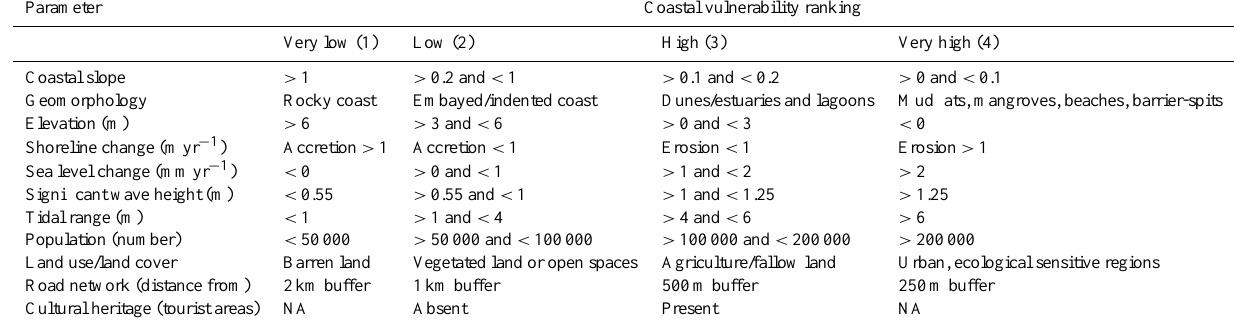
Table 2. Vulnerability ranking